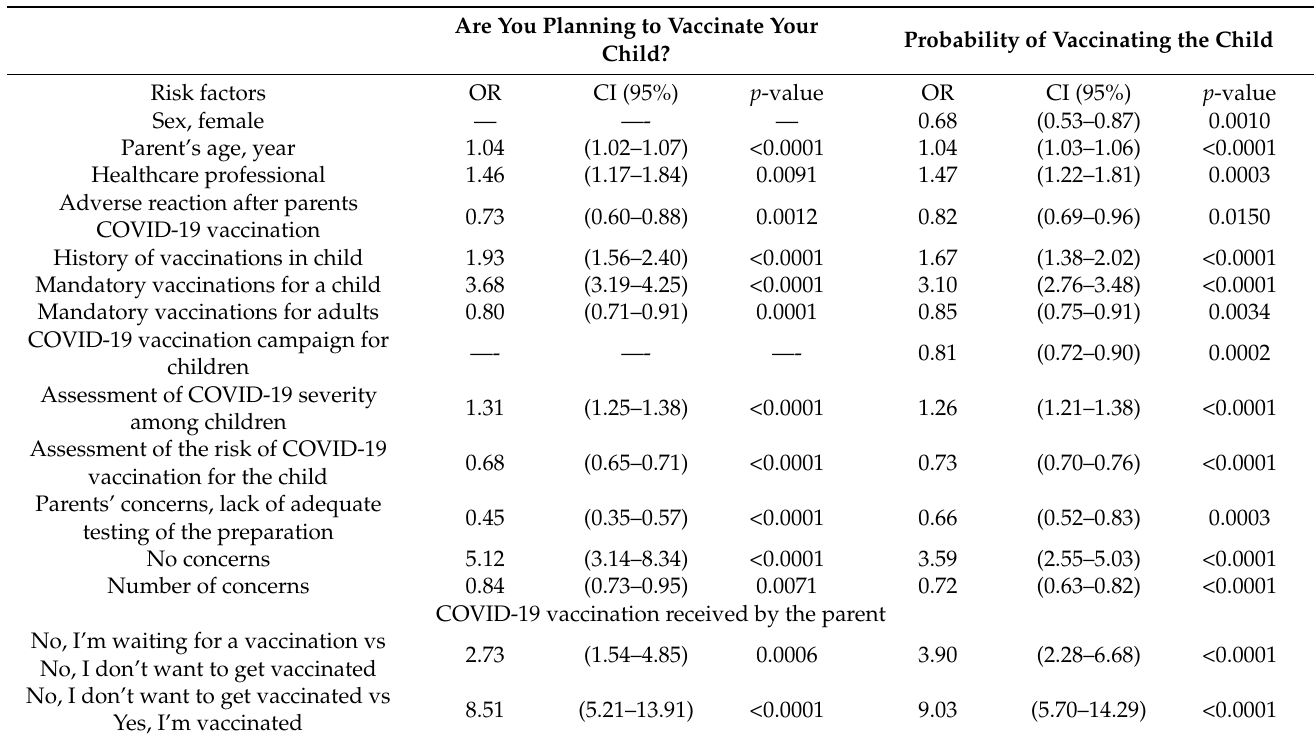
Table 6. Multivariate ordered logistic regression taking into account sociodemographic, one’s own vaccination history, sources of information and major concerns on attitudes towards getting one’s own children vaccinated against COVID-19. Are You Planning to Vaccinate Your Probability of Vaccinating the Child?